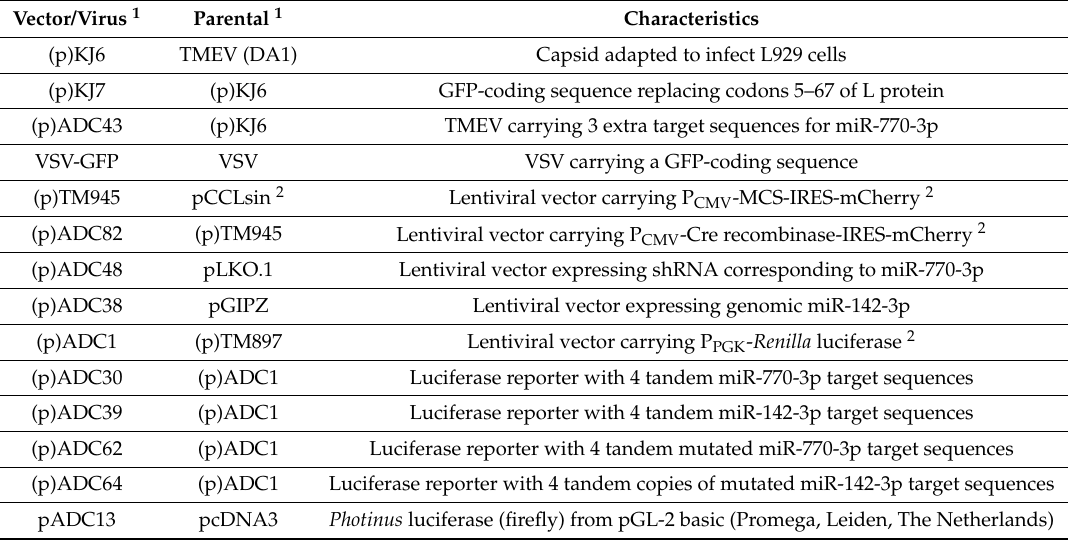
Table 1. Recombinant viruses, lentiviral vectors and reporter vectors used in this study. Vector/Virus